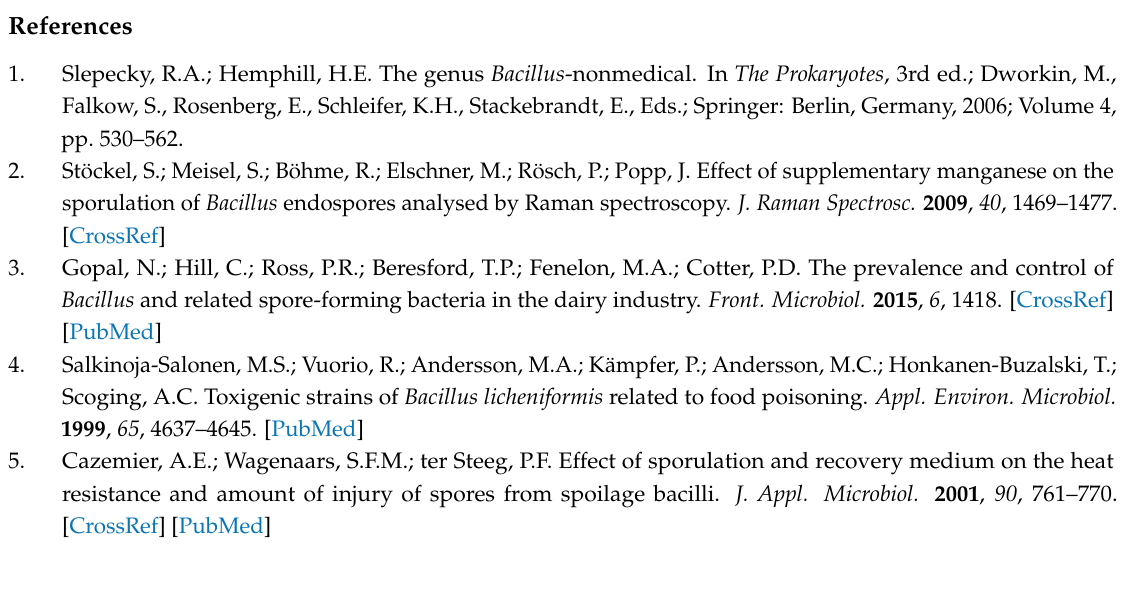
Table S1: Statistical comparison of sporulation of B. licheniformis and B. cereus influenced by calcium and manganese supplementation concentrations, Table S2: Statistical comparison of sporulation of B. subtilis and B. coagulans influenced by calcium and manganese supplementation